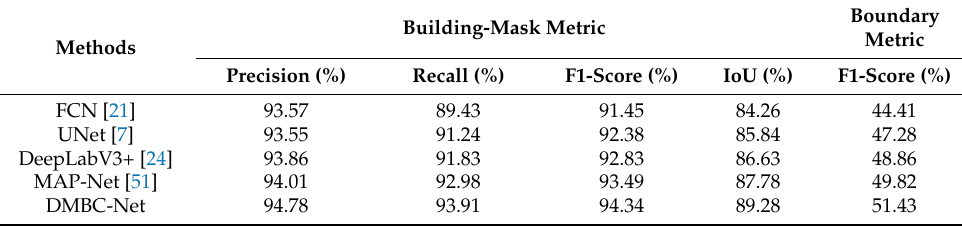
Table 2. Quantitative comparison with state-of-the-art methods on the ISPRS Vaihingen data set.